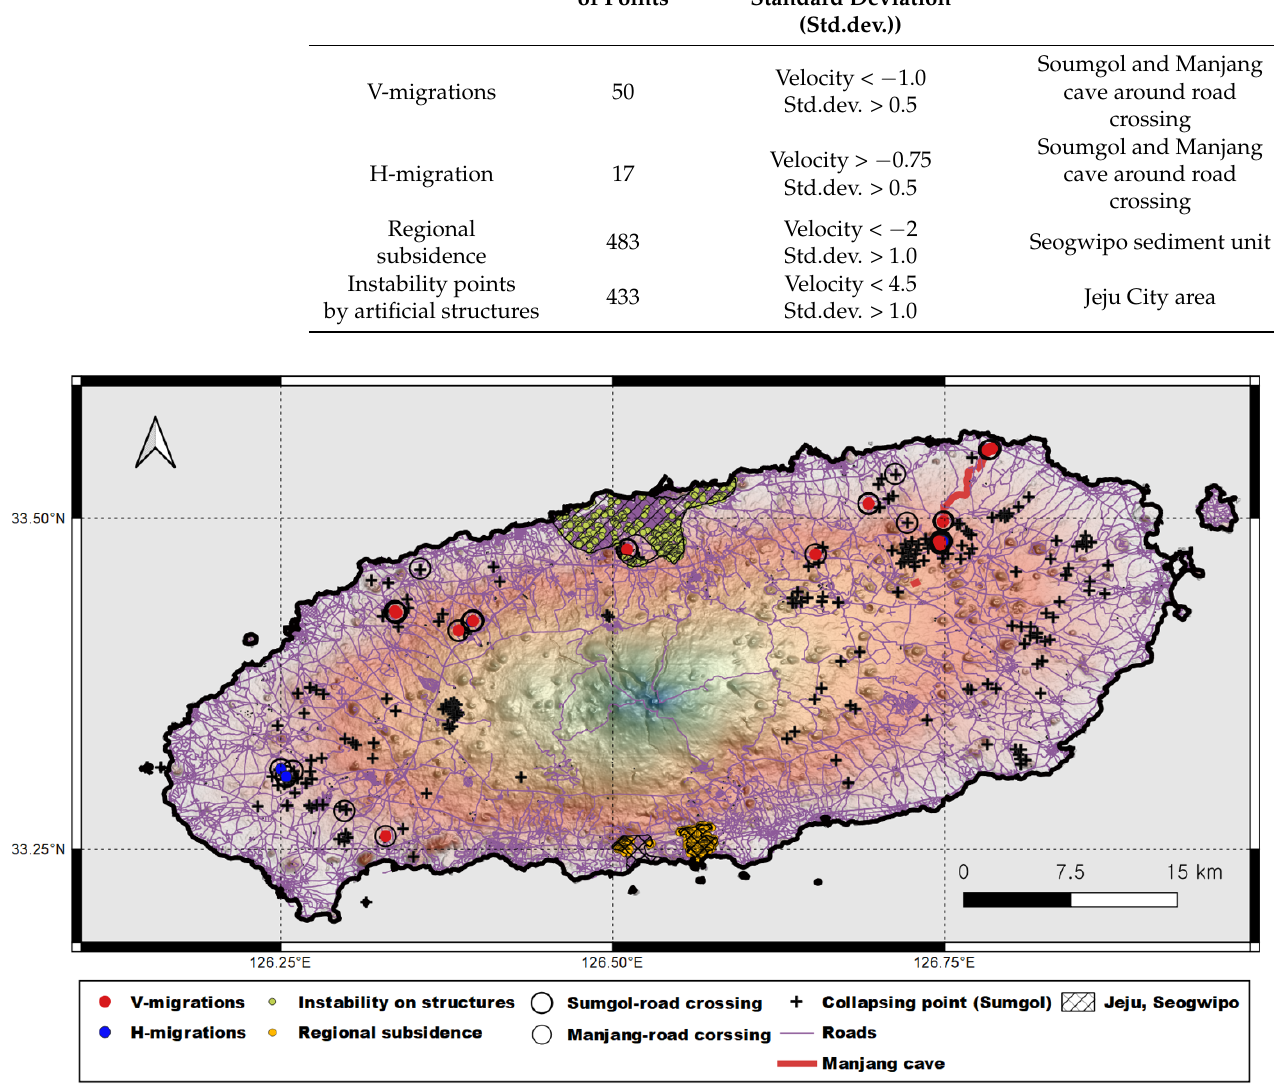
Figure 6. Training point locations of V-migration, H-migration, regional subsidence, and instability points by artificial structures for machine learning. The training vectors for regional subsidence were chosen in Seogwipo City, where Jeju Island’s only sediment unit exists. Training vectors for instability caused by artificial structures were built in the Jeju City area, where the largest buildings are concentrated.